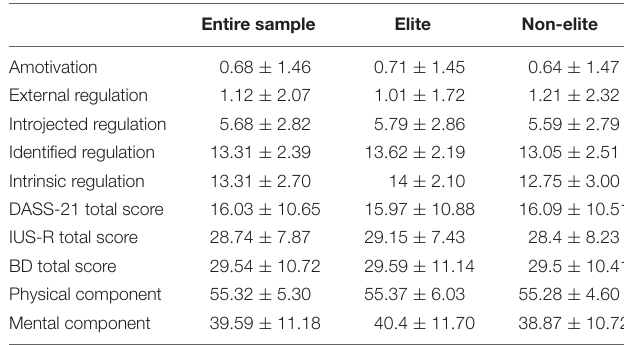
TABLE 2 | Means and standard deviations of psychological variables in the entire sample, in elite and non-elite